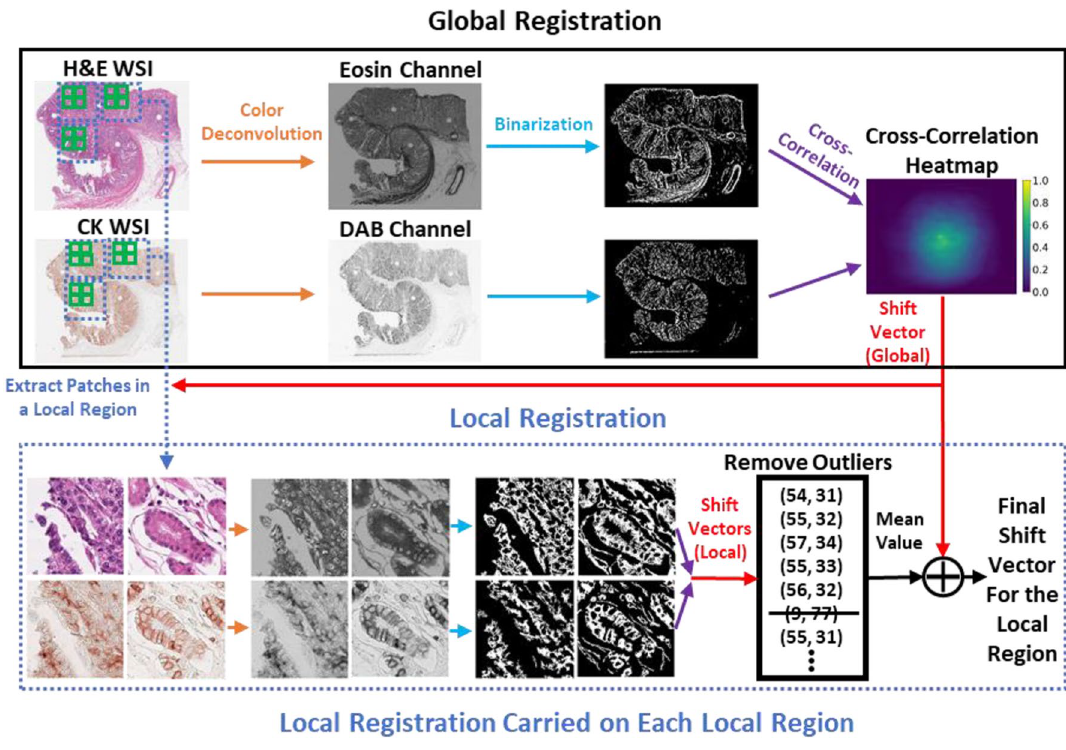
Figure 2. The pipeline of our image registration